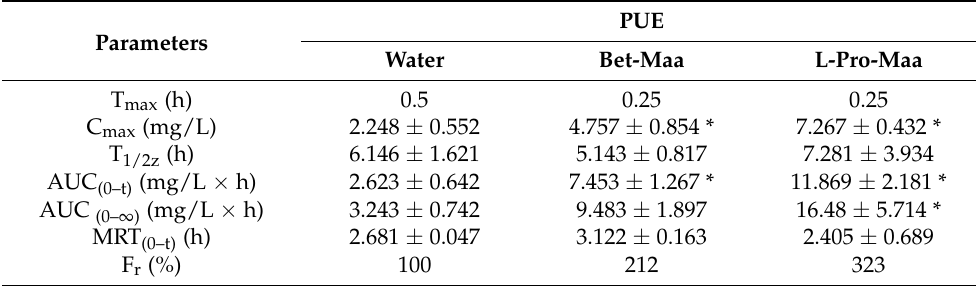
Figure 5. Time course of plasma concentrations (mean ± SD) of PUE in Sprague-Dawley rats following oral administration of 2 g/kg RP in L-Pro-Maa(green), Bet-Maa (red) and water (grey). The error bars represent the standard error base on the plasma concentrations three rats in same group. Table 3. Main pharmacokinetics parameters of PUE after oral administration of the RP extracts with water, Bet-Maa and L-Pro-Maa.